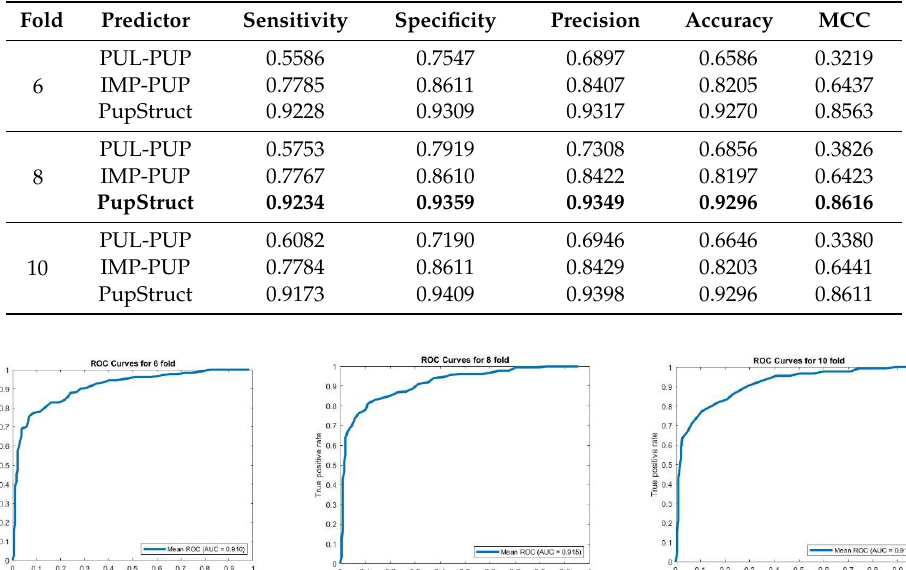
Table 1. Shows comparison of performance assessment of PupStruct and two benchmark predictors for 6-, 8-, 10-fold cross-validation. The highest values in each metric are in bold. Fold Predictor